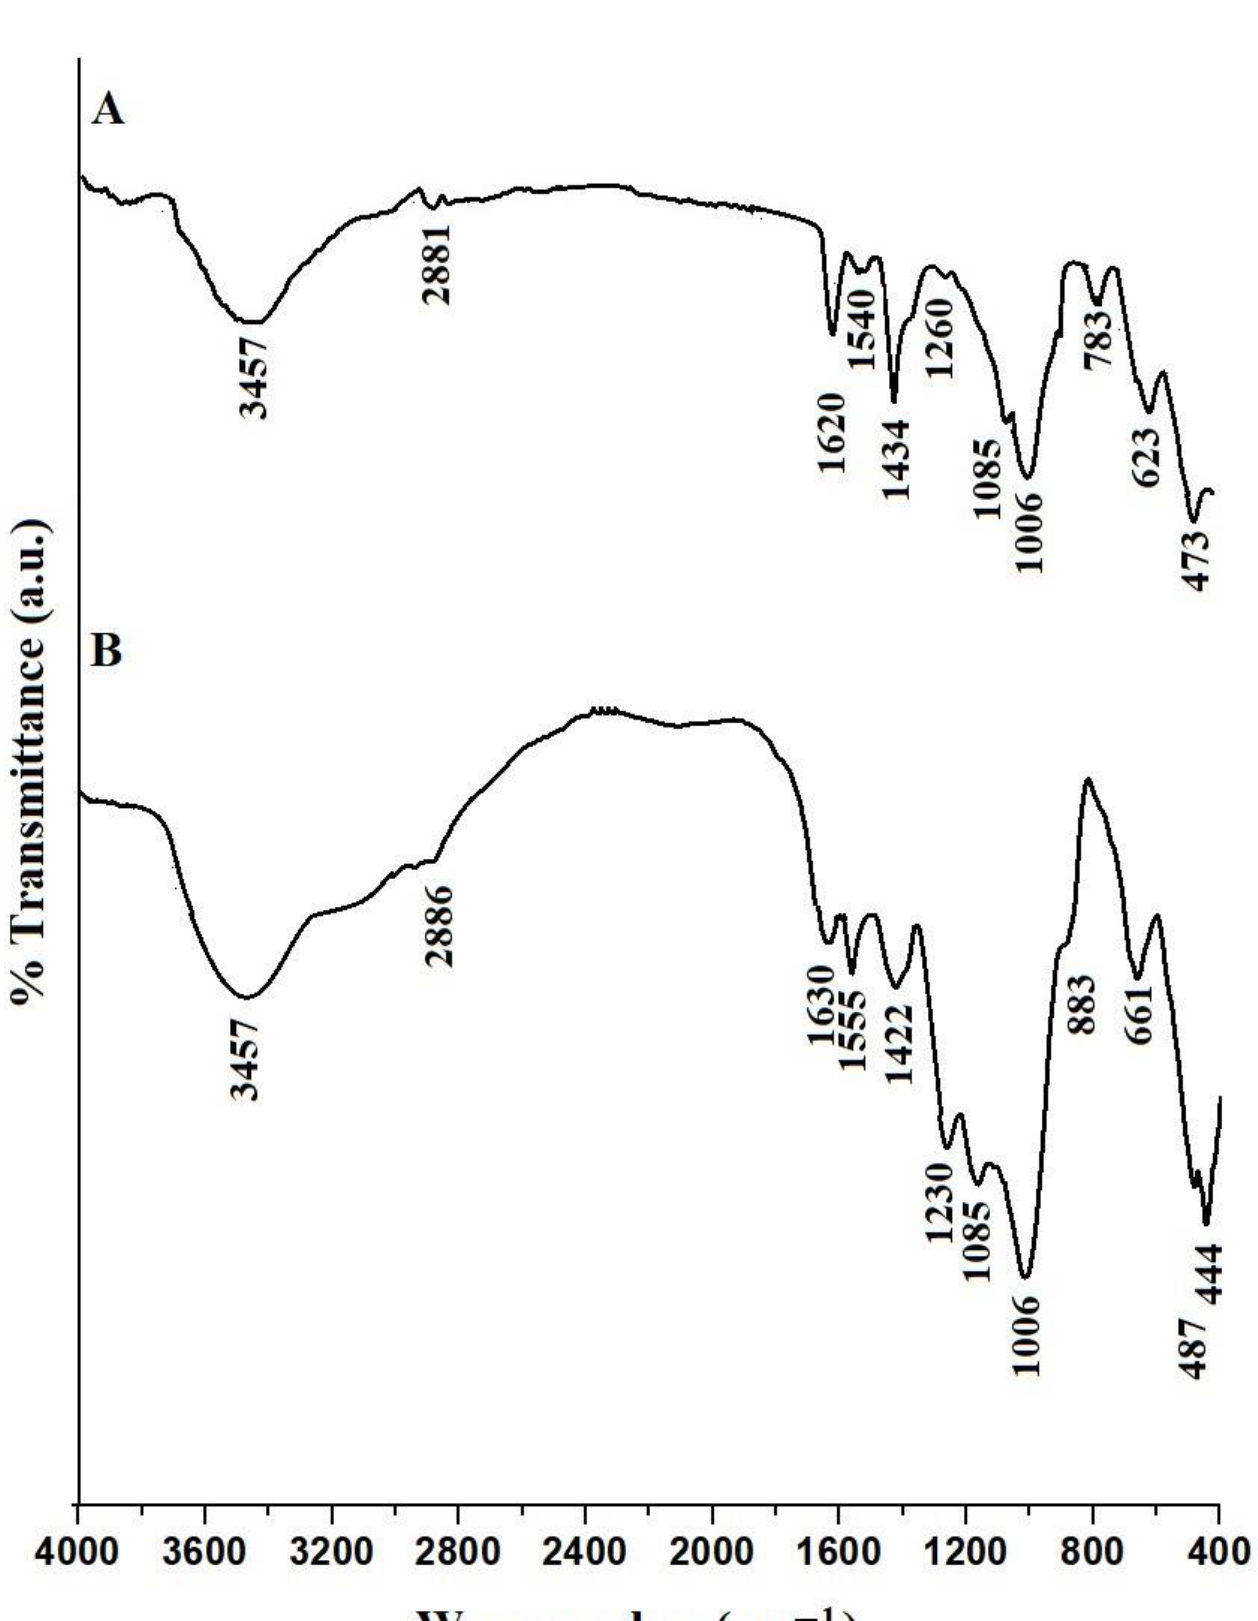
Figure 14. The FT-IR spectra of the Cu(II) – F1S ( A ) and Cd(II) – F1S ( B ).